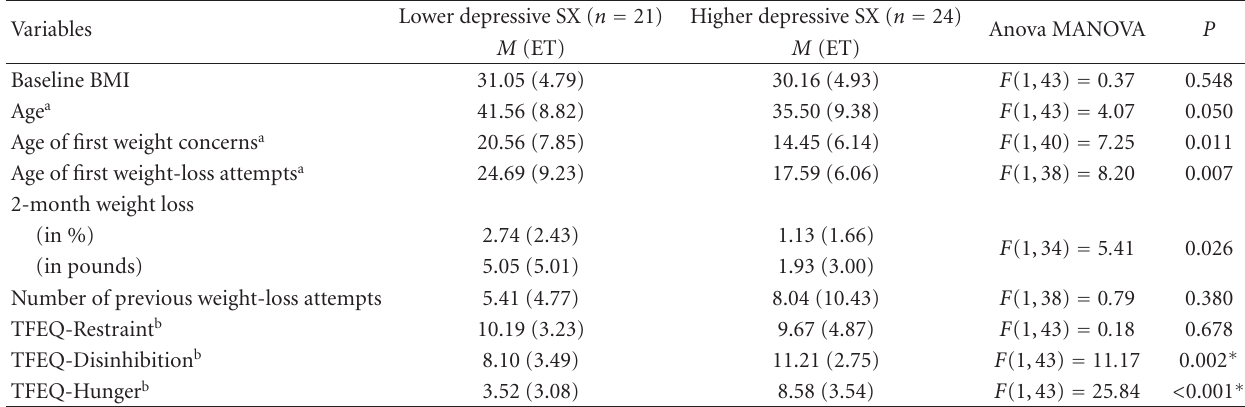
Table 1: Di ff erences between groups for age-, weight, and eating-related variables.